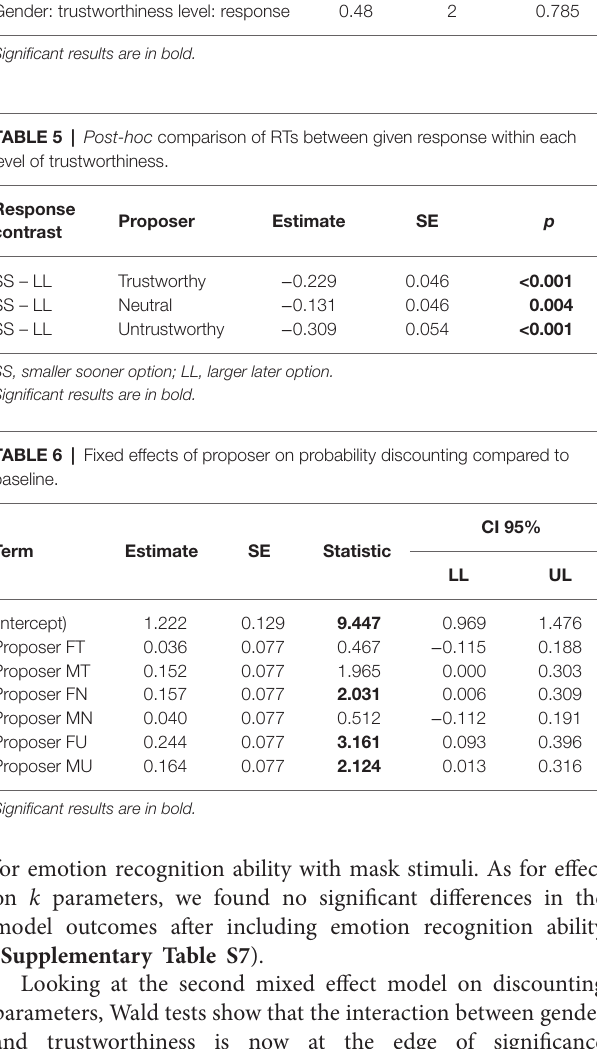
Significant results are in bold.